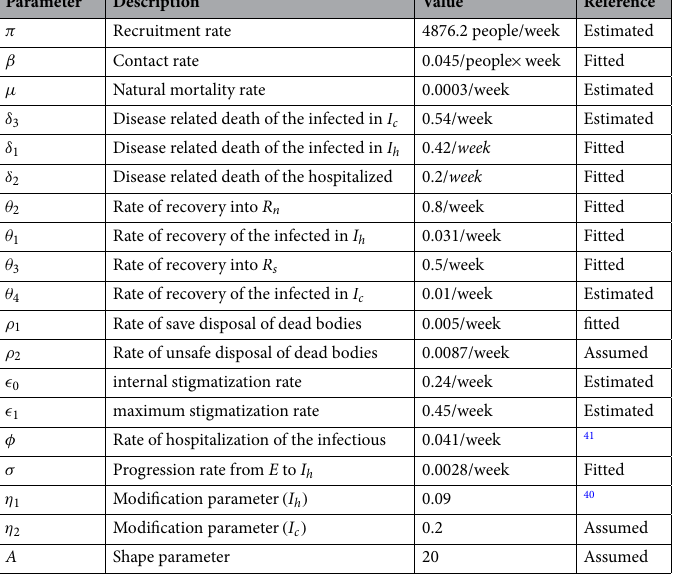
Table 2. Estimated parameter values for model